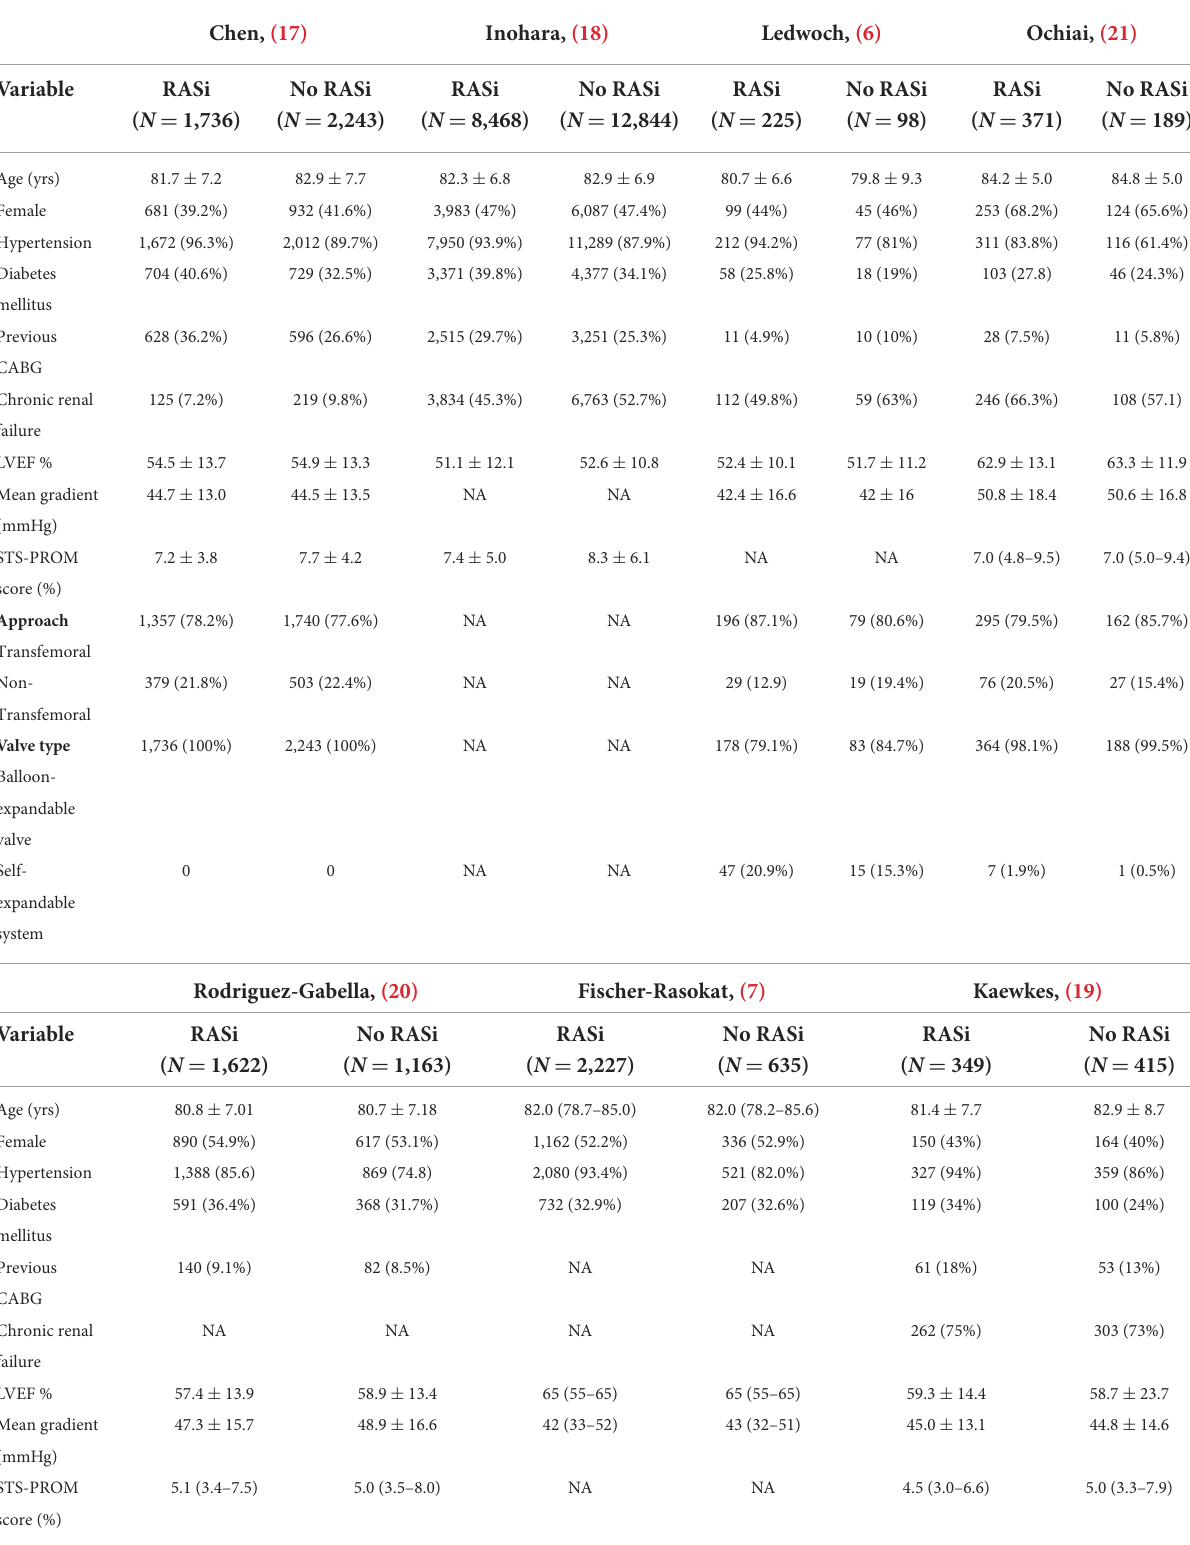
TABLE 2 The Characteristics of included patients. Chen, (17) Inohara, (18) Ledwoch, (6) Ochiai,